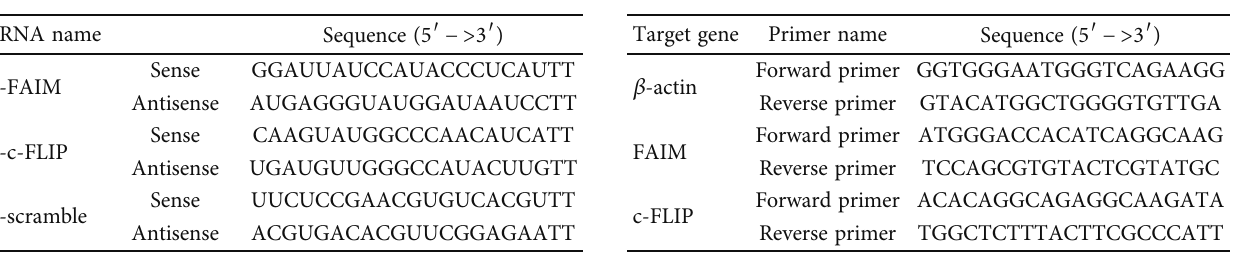
Table 1: siRNA sequences. Table 2: qRT – PCR primer